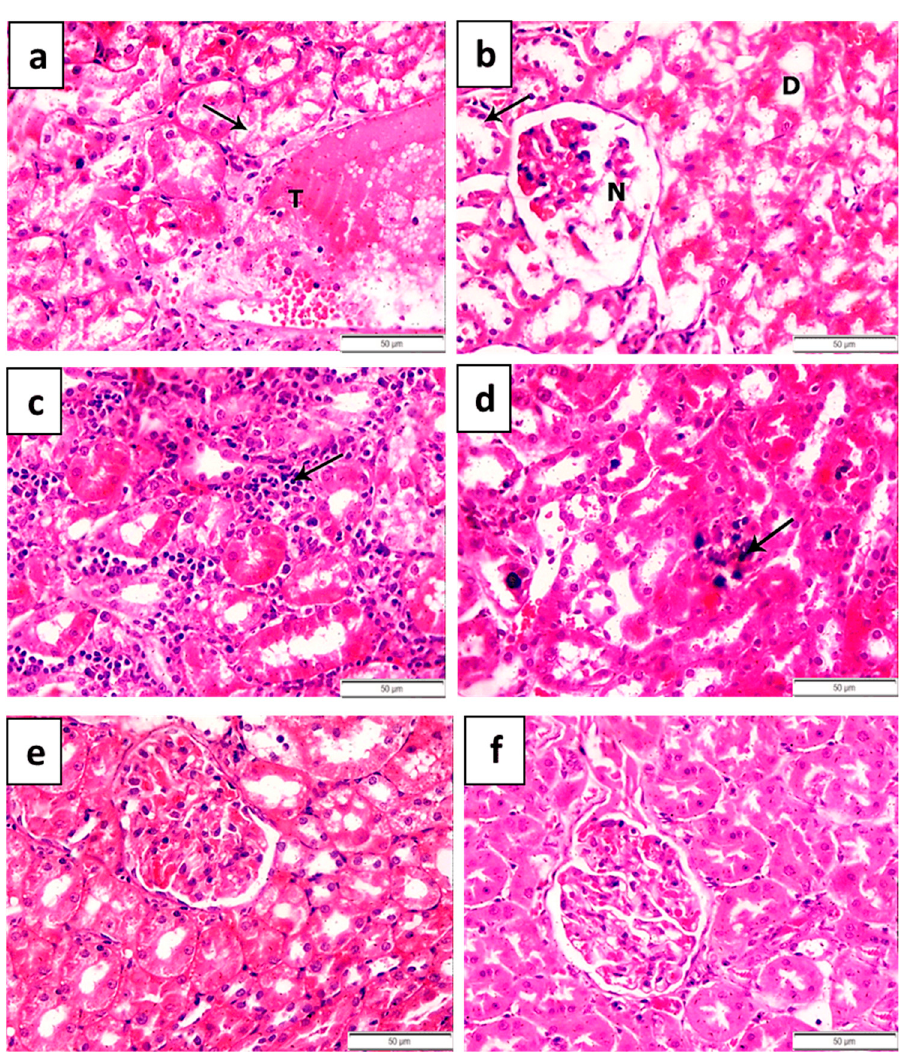
Figure 4. Histopathological features of kidneys in lead-acetate-induced anemic rats ( a – d ) treated with 27 ppm/day iron oxide nanoparticles ( e ) prepared chemically or ( f ) green biosynthesized with Petroselinum crispum leaf extract for 6 weeks. ( a ) Thrombosis of the renal blood vessels (T letter) with degenerative changes of the lining epithelium of the convoluted tubules (arrow). ( b ) Necrosis and atrophy of the glomerular tuft (N letter) with extensive hydropic degeneration of the lining epithelium of some renal tubules (D letter) and its necrosis with pyknotic nuclei in other tubules (arrow). ( c ) Inter-tubular mononuclear leukocytic cellular infiltration, mainly lymphocytes (arrow). ( d ) Precipitation of lead pigment either in the lining epithelium of the convoluted tubules or in the lumen of renal tubules (arrow ×1000). ( e ) Vacuolation of the lining epithelium of some renal tubules (arrow) and ( f ) fibrous connective tissue proliferation around the degenerated renal tubules (arrow).